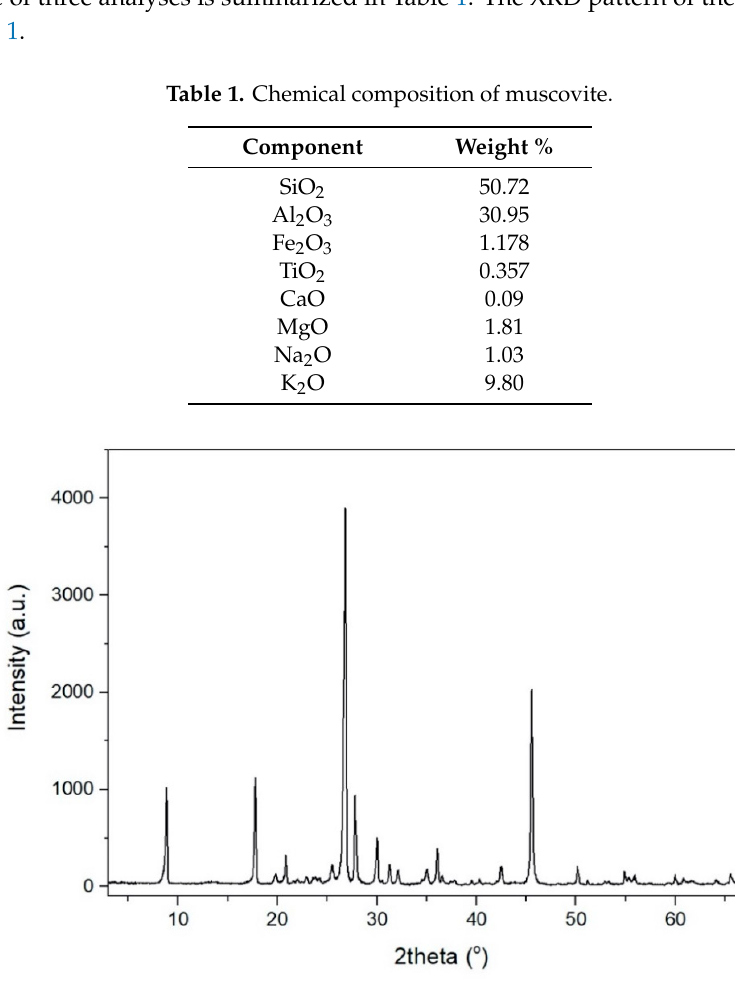
Figure 1. The XRD pattern of the raw muscovite ore.